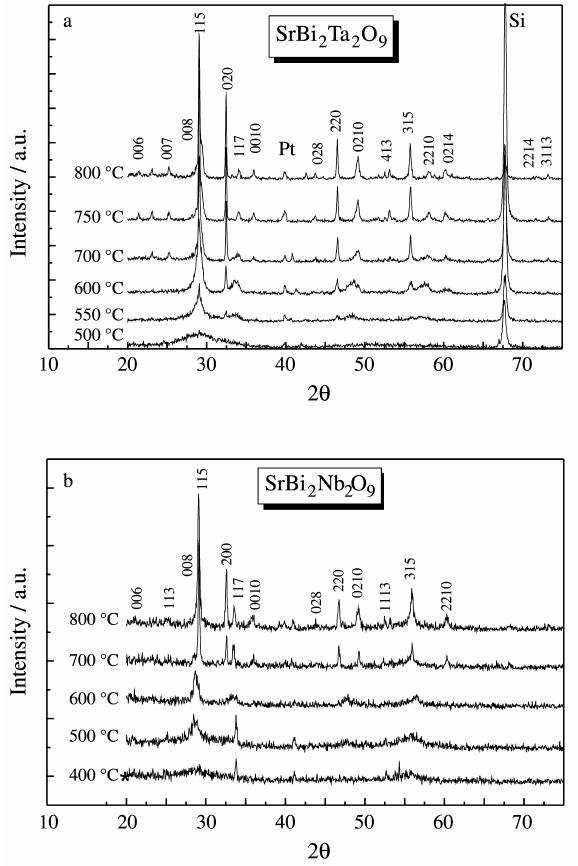
Figure 3. Diffraction patterns of the films treated at different tempera- tures: (a) SBT and (b)